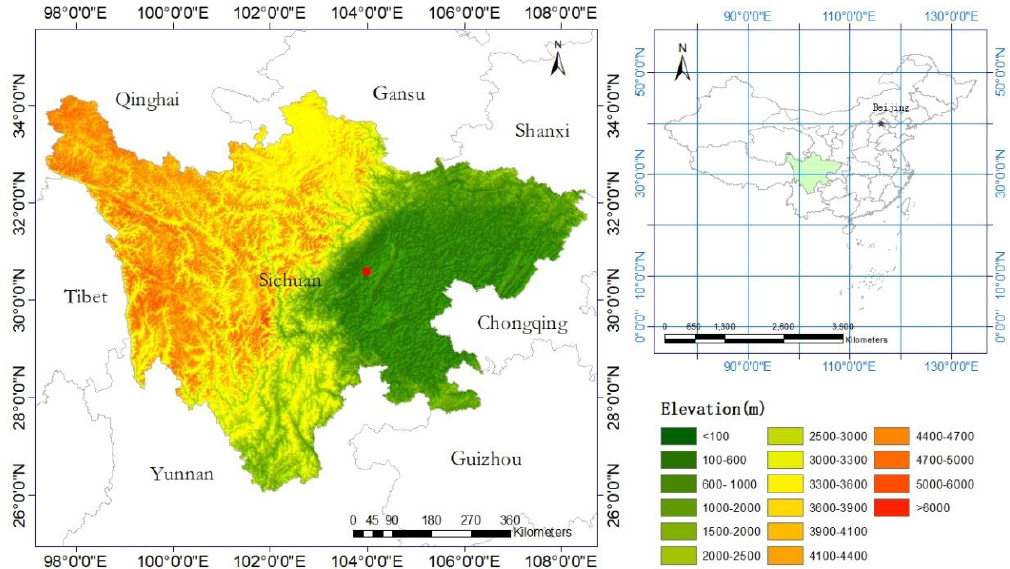
Figure 1. Topographic map of Sichuan province and location of the Sun-sky radiometer Observation NETwork (SONET) Chengdu site (marked with red dot). Data source is ASTER GDEM (Advanced Spaceborne Thermal Emission and Reflection Radiometer Global Digital Elevation Model).